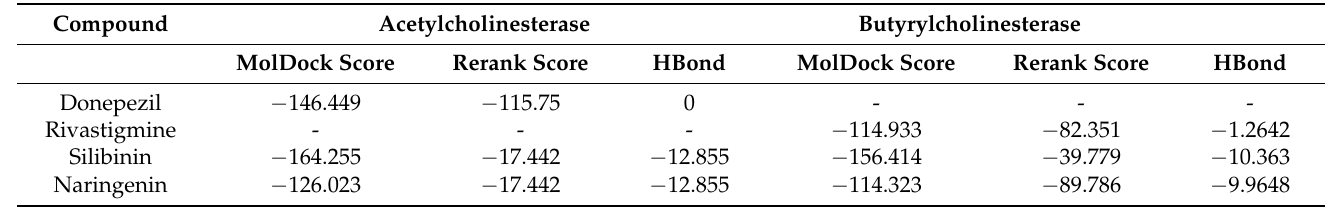
Table 6. Comparative analysis of ligand interactions with silibinin and naringenin with cholinesterase